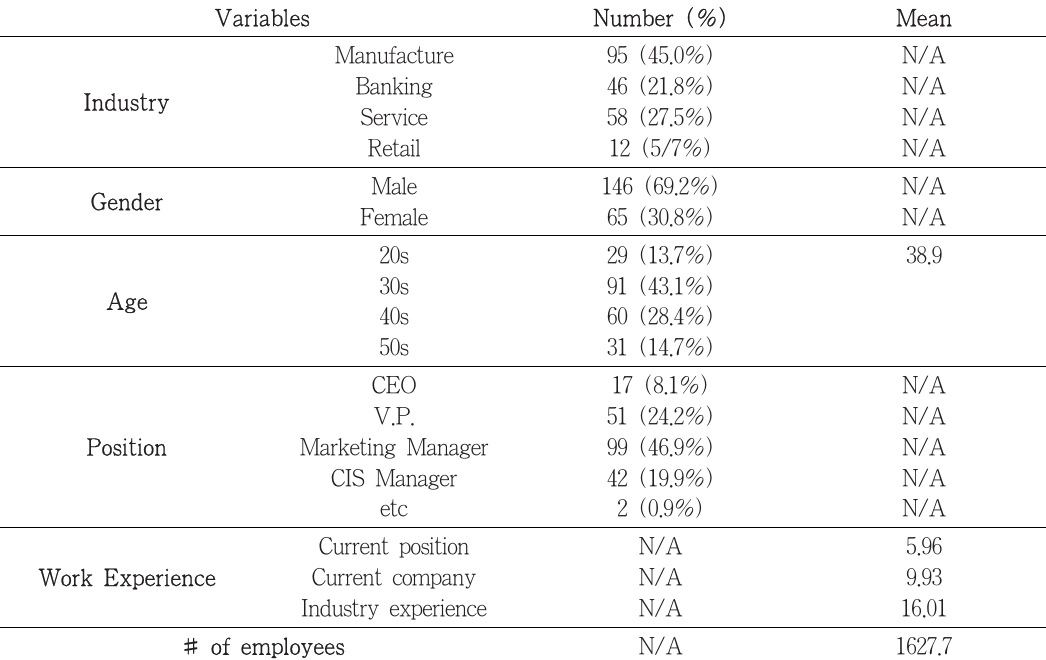
<Table 4> Demographic Characteristics of the Sample